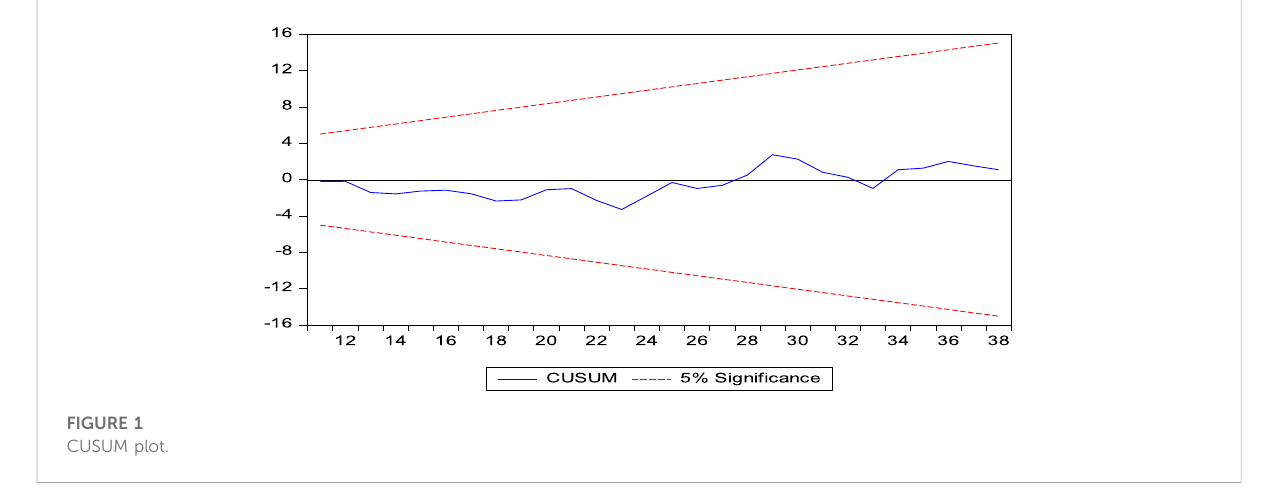
FIGURE 1 CUSUM plot.